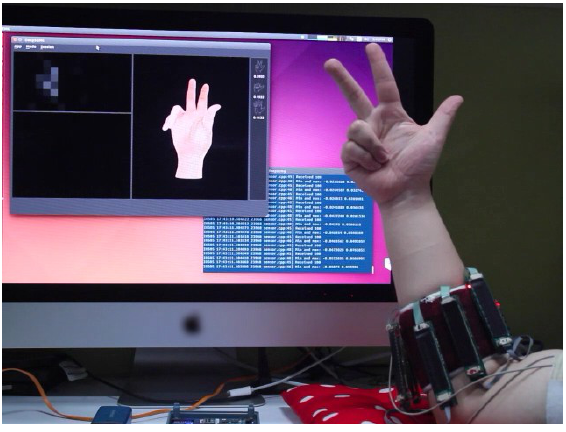
Figure 4. The HD-sEMG-based gesture recognition system. The software subsystem displays the recognized hand gesture and the recorded HD-sEMG image in